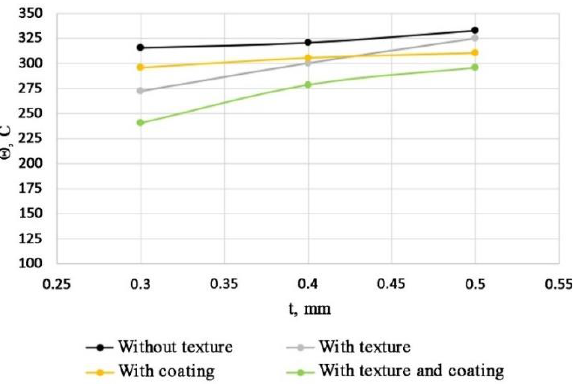
Figure 8. Dependence of the cutting temperature on the cutting depth for various tools at a cutting speed of V = 17 m/min and S = 0.15 mm/rev. speed of V = 17 m/min and S = 0.15 mm/rev.